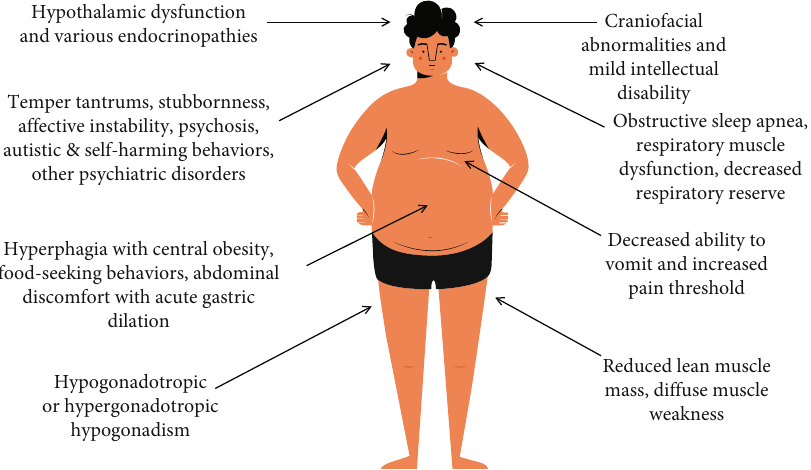
Figure 1: Clinical features of Prader-Willi syndrome